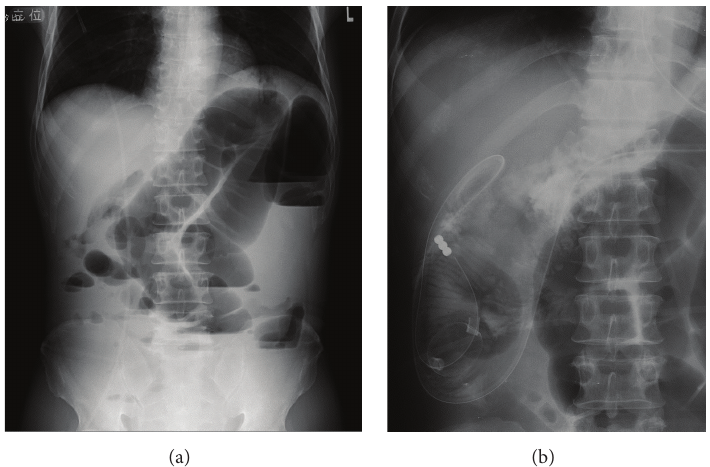
Figure 1: An abdominal X-ray examination revealed the dilation of the colon and niveau (a). At the insertion of an ileus tube, the C-loop of the duodenum was observed to be absent and the small intestine was located on the right side of the abdomen (b).